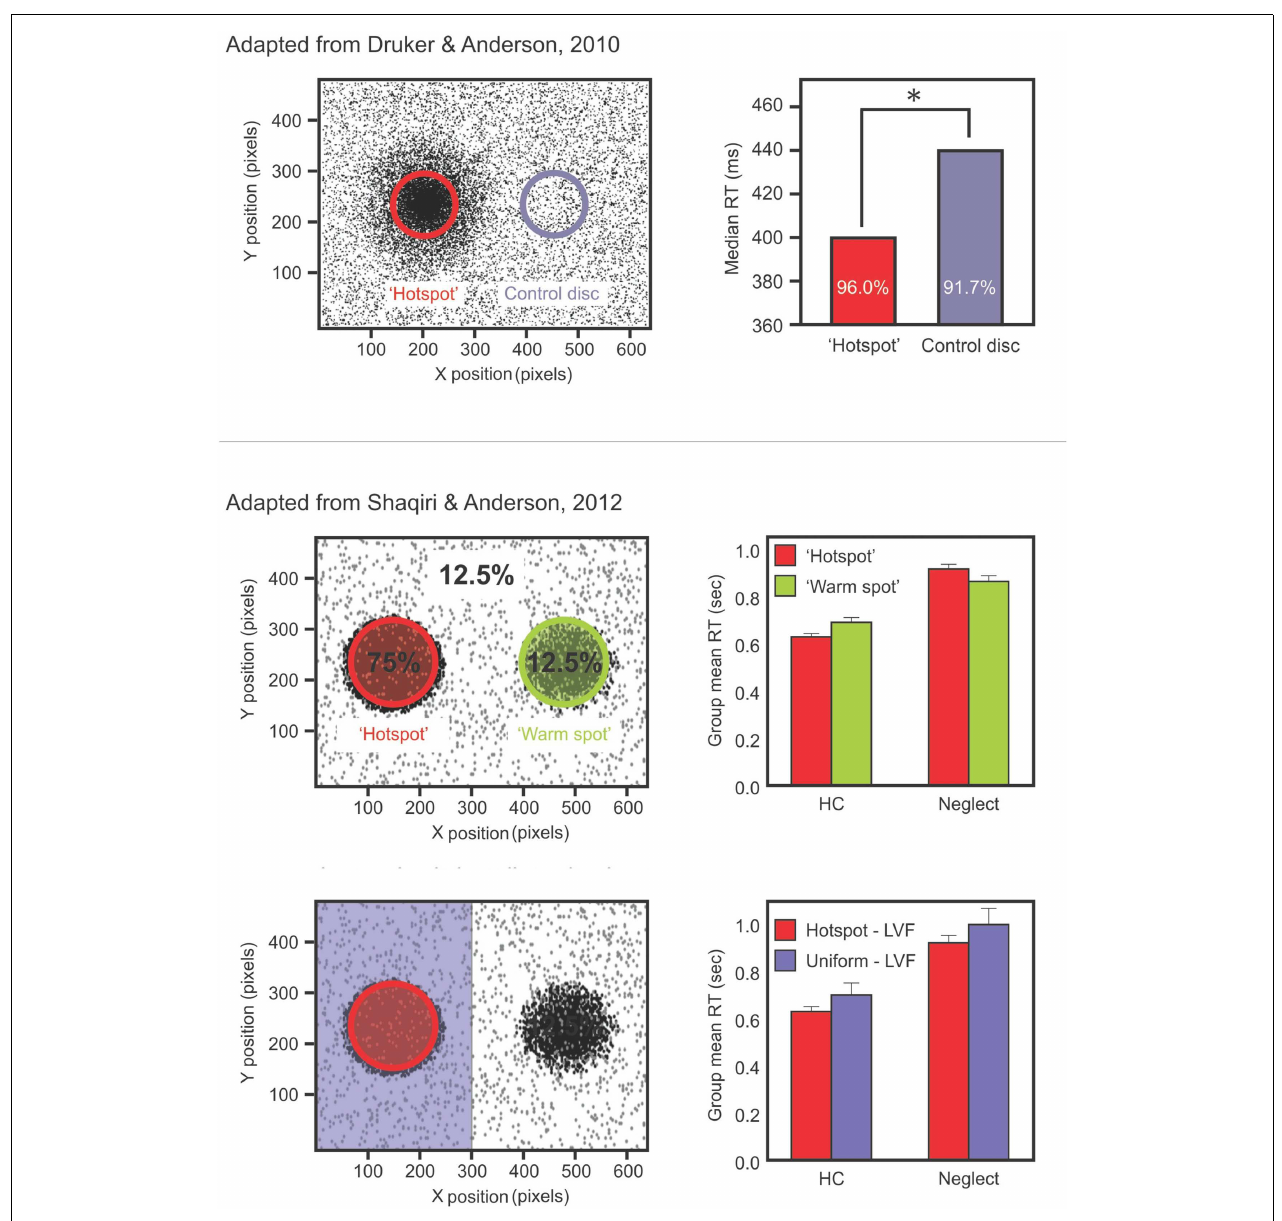
(2012a).This is a modified version of the Druker and Anderson (2010) task in a group of healthy older controls (HCs) and right brain damaged (RBD) patients with Neglect. Contrary to HCs, Neglect patients failed to show a benefit in RT for targets presented in a contralesional, high probability region (Shaqiri and Anderson, 2012a). Lower panels show HCs and neglect patients’ RT for the hotspot and the rest of the left-sided trials: although overall slower on the left, Neglect patients were sensitive to the biased distribution of the